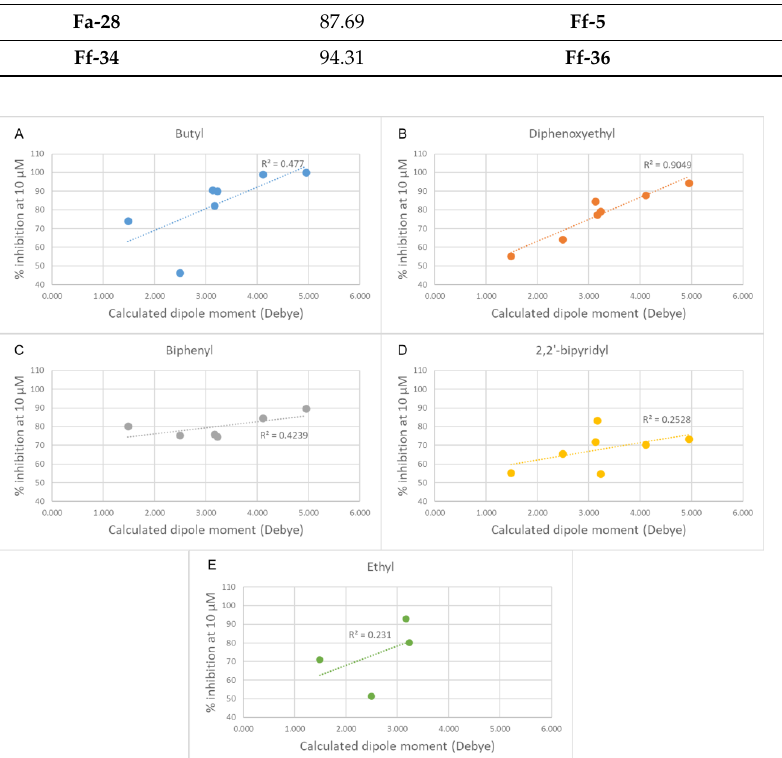
Figure 7. Plots of the experimental percentage inhibitory potency against the calculated dipole moments of the cationic heads for each class of compounds. A Butyl linker class. B Diphenoxyethyl linker class. C Biphenyl linker class. D 2,2′-bipyridinyl linker class. E Ethyl linker class. In each plot, the linear fit is shown as a dashed line.